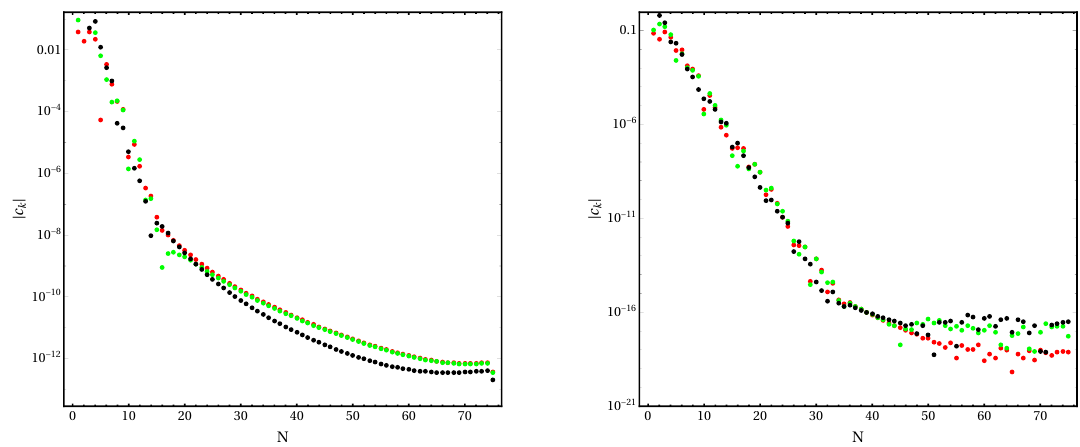
Figure 15 . Convergence in the momentum diffusion sector without (left) and with (right) the co- ordinate mapping % 7→ % 2 . The c are the Chebychev coefficients of the numerical solution and N is k the number of gridpoints of the Chebychev grid used to discretize the radial direction. The param- √ eters are γ = 2 / 3 , ˜ B = 109 . 658 , ˜ µ = 7 . 5 and the fluctuations are h (red, green, tx , h zx , a x